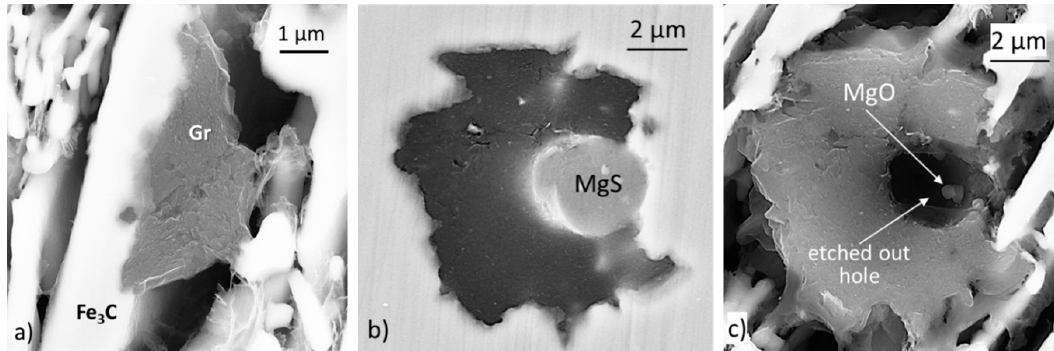
Figure 28. Nucleation of graphite in the iron without Mg (<0.010% Mg) after 4 min at temperature: ( a ) nucleation on iron carbide; ( b ) nucleation on an Mg sulfide; ( c ) MgO nucleus in the MgS inclusion in (b); the MgS was etched away during deep etching at room temperature, reproduced from [111] with permission from Springer.